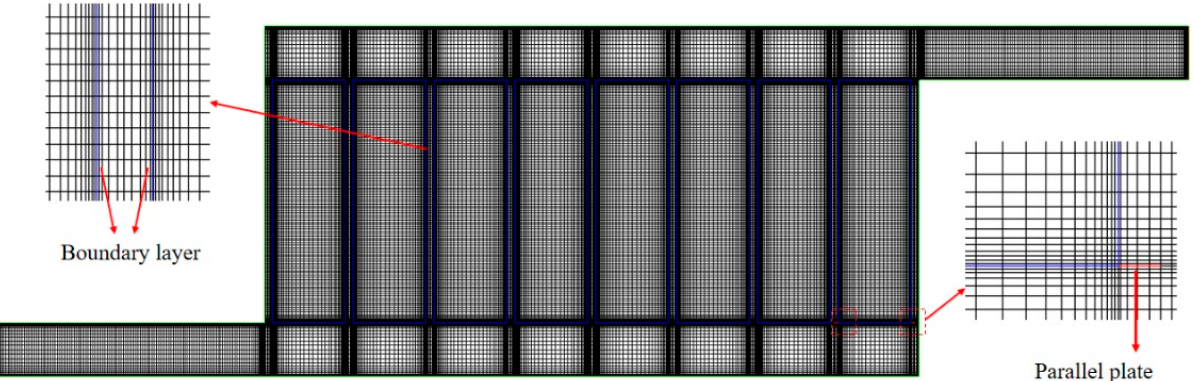
Energies 2021 , 14 , x FOR PEER REVIEW 7 of 16 Figure 3. Grid and partial enlargement of the model. Figure 3. Grid and partial enlargement of the model.